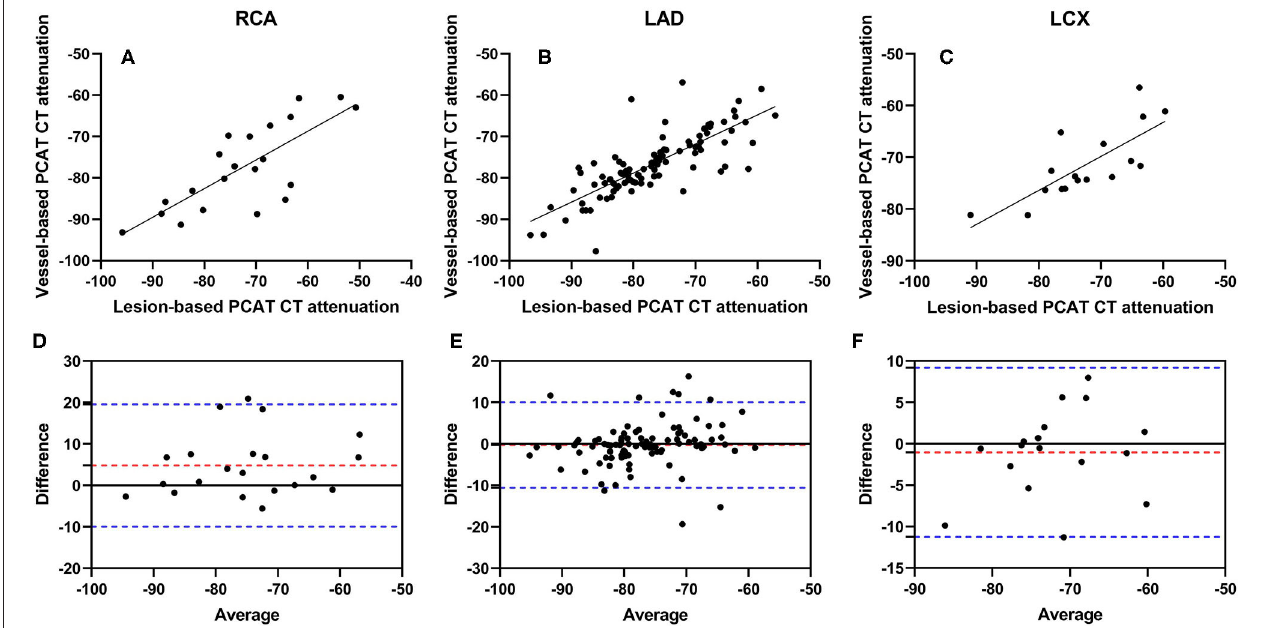
FIGURE 3 | Correlation and Bland-Altman plots of vessel-based and lesion-based PCAT CT attenuation in different coronary arteries. Pearson correlation analyses show the correlation vessel-based and lesion-based PCAT CT attenuation in RCA (A) , LAD (B) and LCX (C) , respectively. Bland-Altman plots show PCAT CT attenuation between vessel-based and lesion-based in RCA (D) , LAD (E) and LCX (F) . The red dotted lines represent the mean difference (bias), and the blue dotted lines represent the 95% limits of agreement. LAD, left anterior descending artery; LCX, left circumflex artery; PCAT, pericoronary adipose tissue; RCA, right coronary artery.